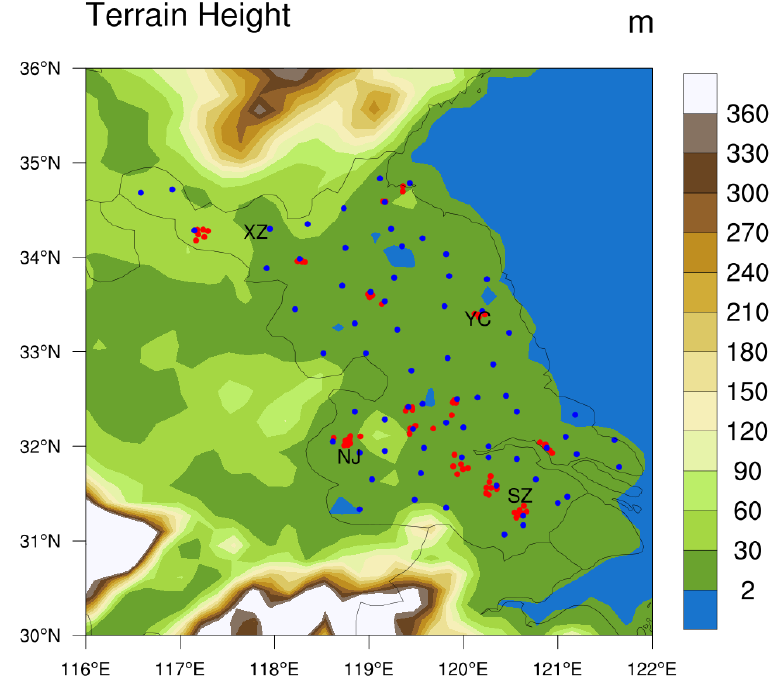
Figure 3 . Locations of 72 environmental monitoring stations (red dot) and 70 meteorological observation stations (blue dot) in Jiangsu Province.